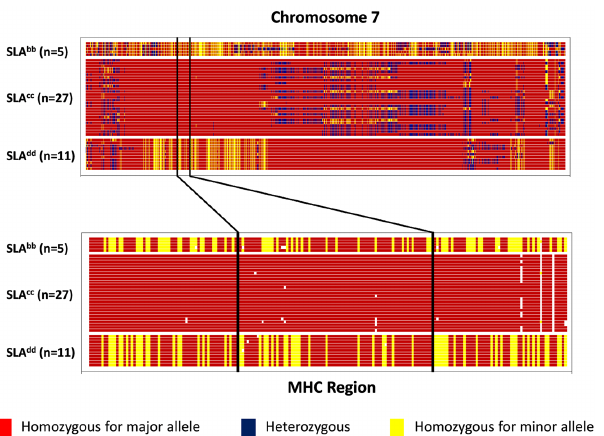
blocks. Vertical lines depict SNPs, colour-coded according to genotype. White lines represent ungenotyped SNPs or null alleles. A ‘ major ’ allele is the more frequent allele and a ‘ minor ’ allele is the less frequent allele of a pair of alleles within a given line. Locations of SNPs within the chromosome run in ascending numerical order from left to right.